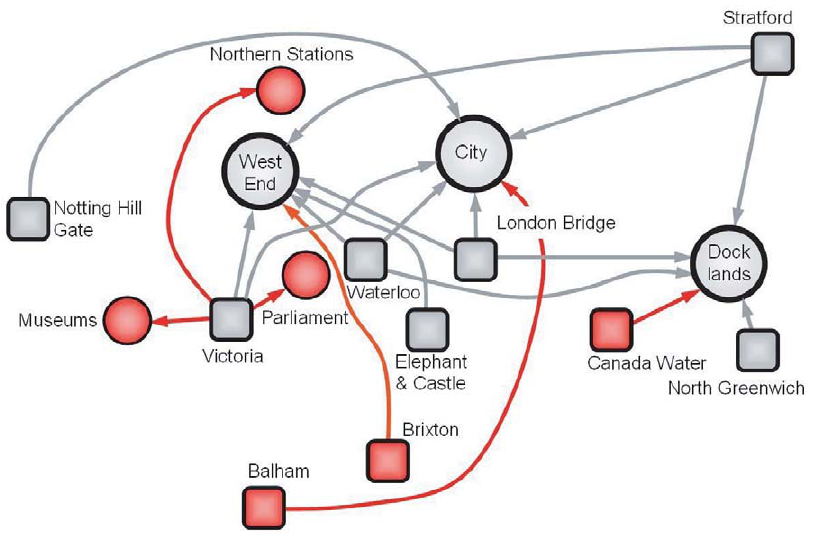
Figure 6. Structure of flows at 20% and 40% of the total flow. When considering the most important flows from stations to centers such their sum represents 20% of the total flow in the network, we observe sources (represented as squares) with outdegree k out ~ 3 such as London Bridge, Stratford, or Waterloo connecting to three different centers (represented as circles), as well as sources with k out ~ 2 (eg. Victoria) and k out ~ 1 (eg. Elephant and Castle). We also show how the pattern of flows is constructed iteratively when we go to larger fraction of the total flow (from 20% shown in black to 40% shown in red). We represent in red the new sources, centers and connections. The new sources connect to the older centers (eg. West End , City , etc) and the existing sources (eg. Victoria ) connect to new centers (eg. Northern stations , Museums , and Parliament ).